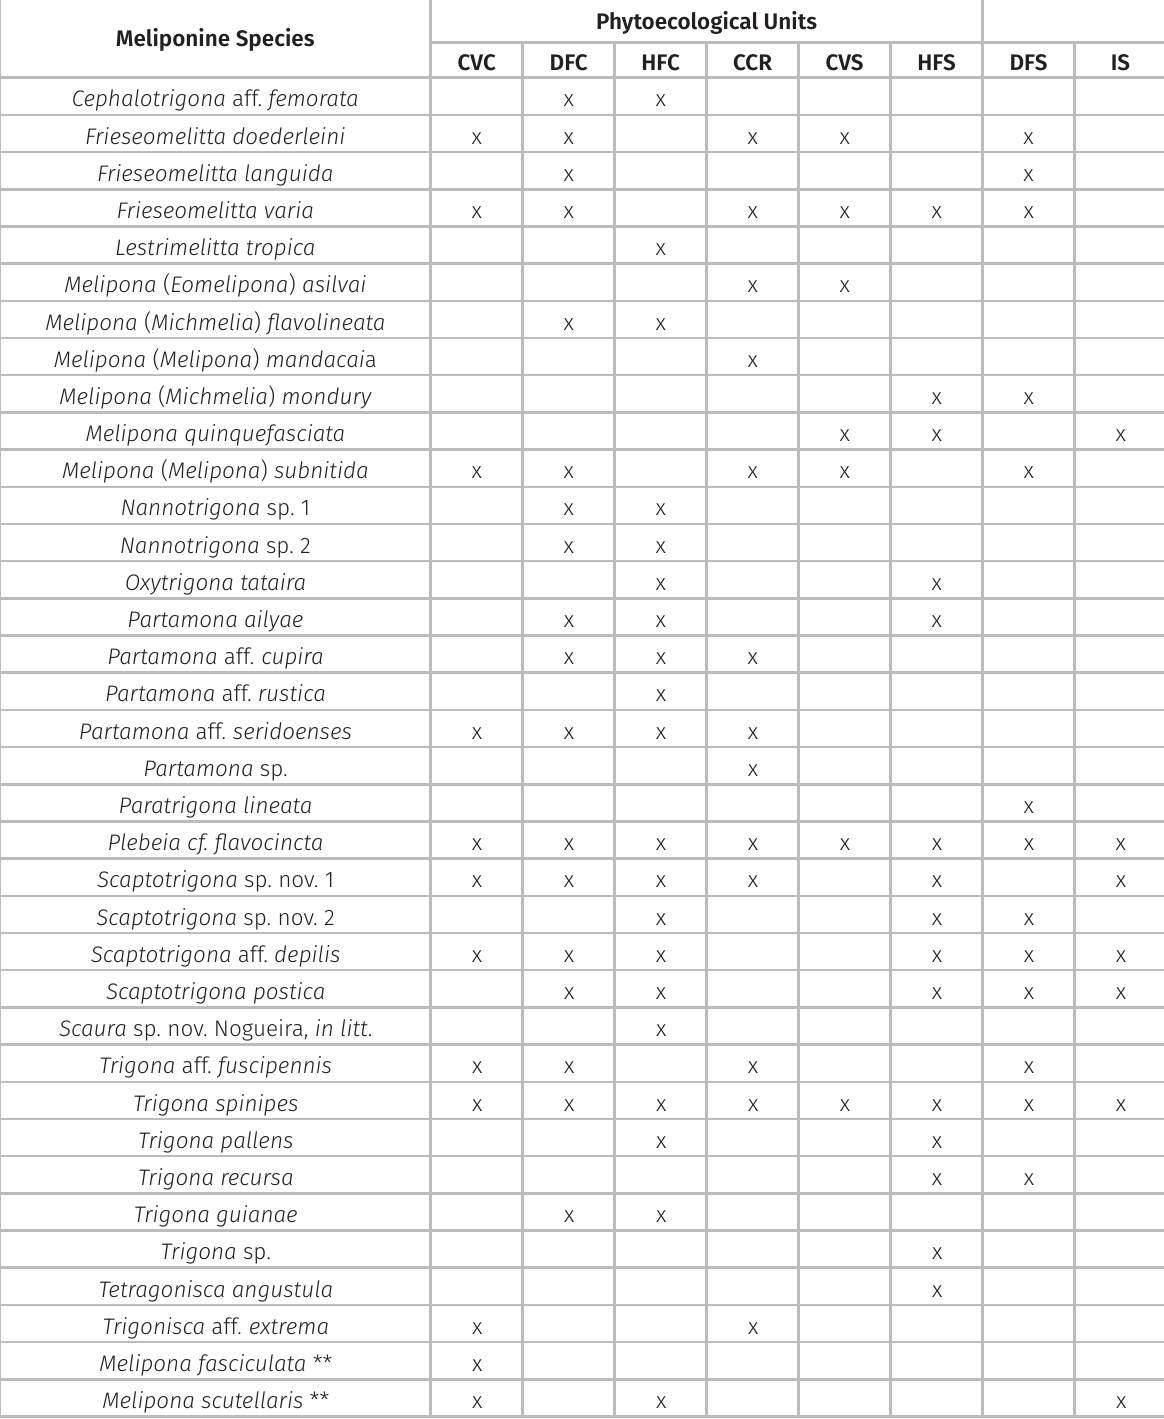
Table II. Occurrence of meliponine species in eight phytoecological Units of the State of Ceará in 2013 and 2014. Phytoecological Units Meliponine Species CVC DFC